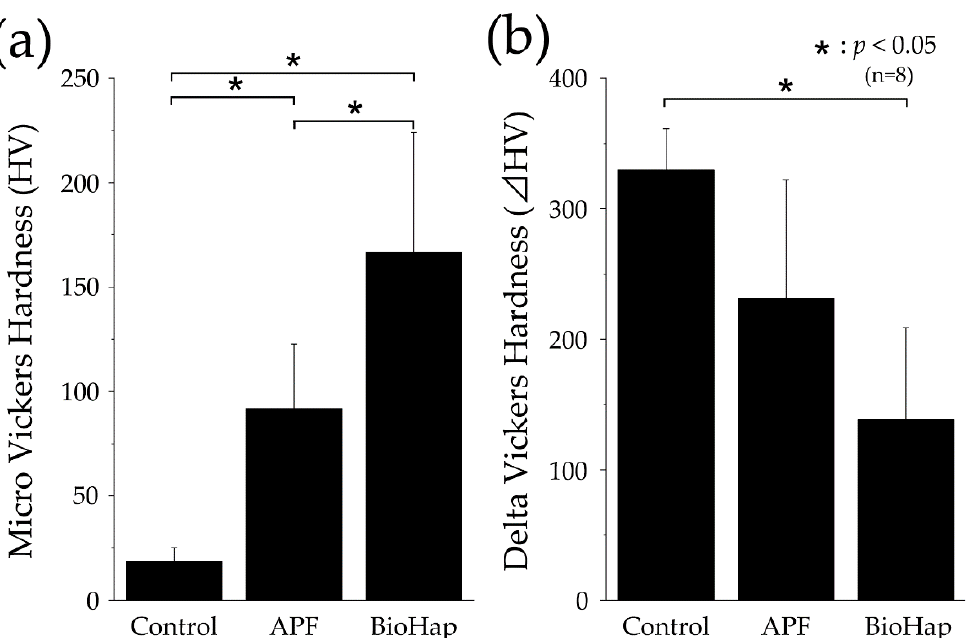
Figure 3. Micro-Vickers hardness (HV) measurements. ( a ) Graph of micro-HV values after acid challenge (n = 8, * p < 0.05). ( b ) Graph of Δ HV values (differences in HV values between the reference and experimental surfaces; n = 8, * p < 0.05).